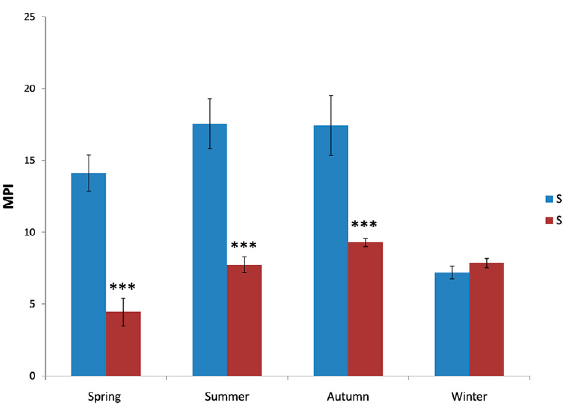
results are represented as mean ± sd (n=6 pooled individuals). The statistical differences between sampling sites are represented at 5%: *p<0.05; **p<0.01; ***p<0.001 using one-way ANOVA. The statistical differences between seasons are represented at 5%: #p<0.05; ##p<0.01; ###p<0.001 using